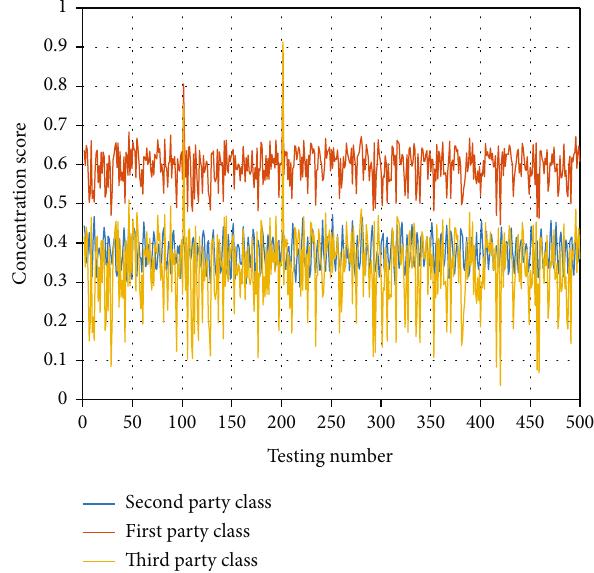
Figure 6: Partial di ff erential equation face recognition concentration analysis evaluation model class concentration score broken line